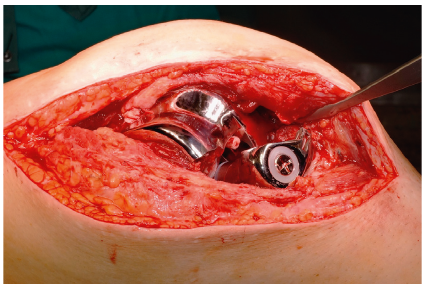
Figure 2: Intraoperative findings showing a fractured lateral condyle of the femoral component.